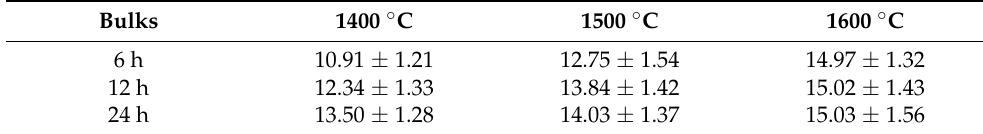
Table 6. The sintered Gd 2 O 3 bulks’ fracture toughnesses/MPa · m 0.5 .